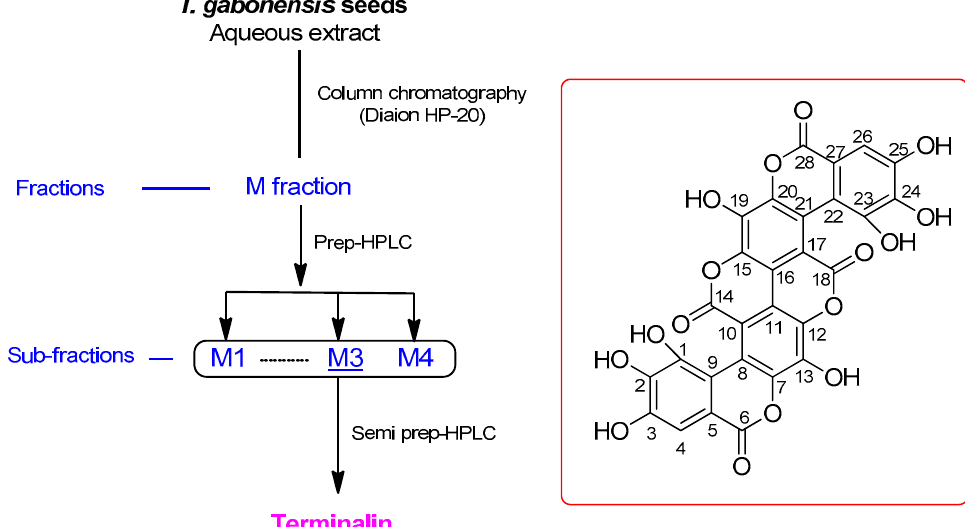
Figure 1. Schematic representation of the isolation of terminalin and its chemical structure.